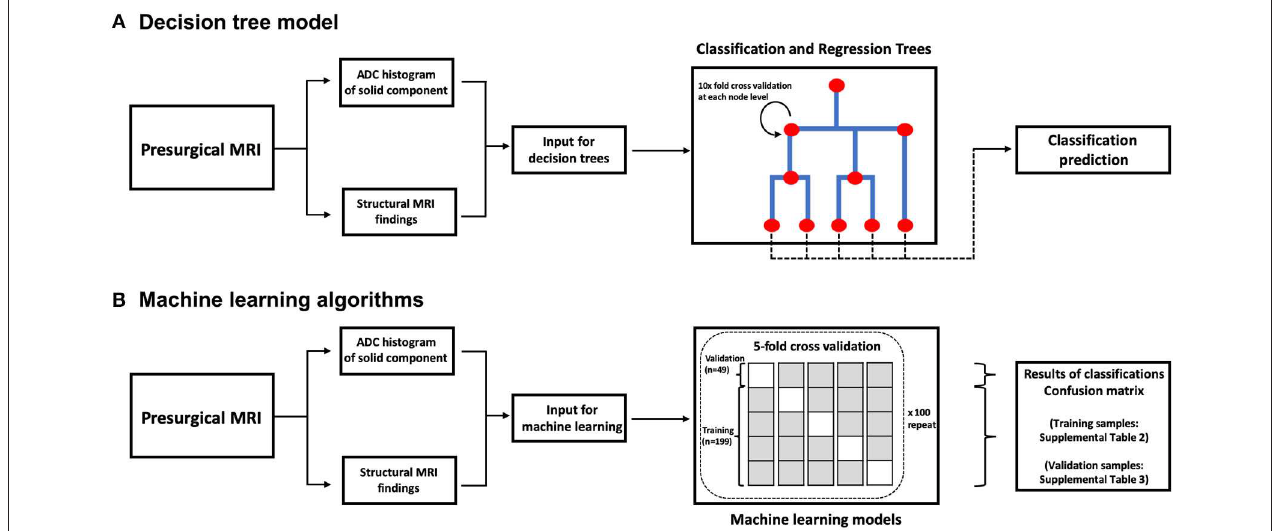
FIGURE 2 | A block diagram of decision tree model (A) and machine learning algorithms (B) . ADC, apparent diffusion